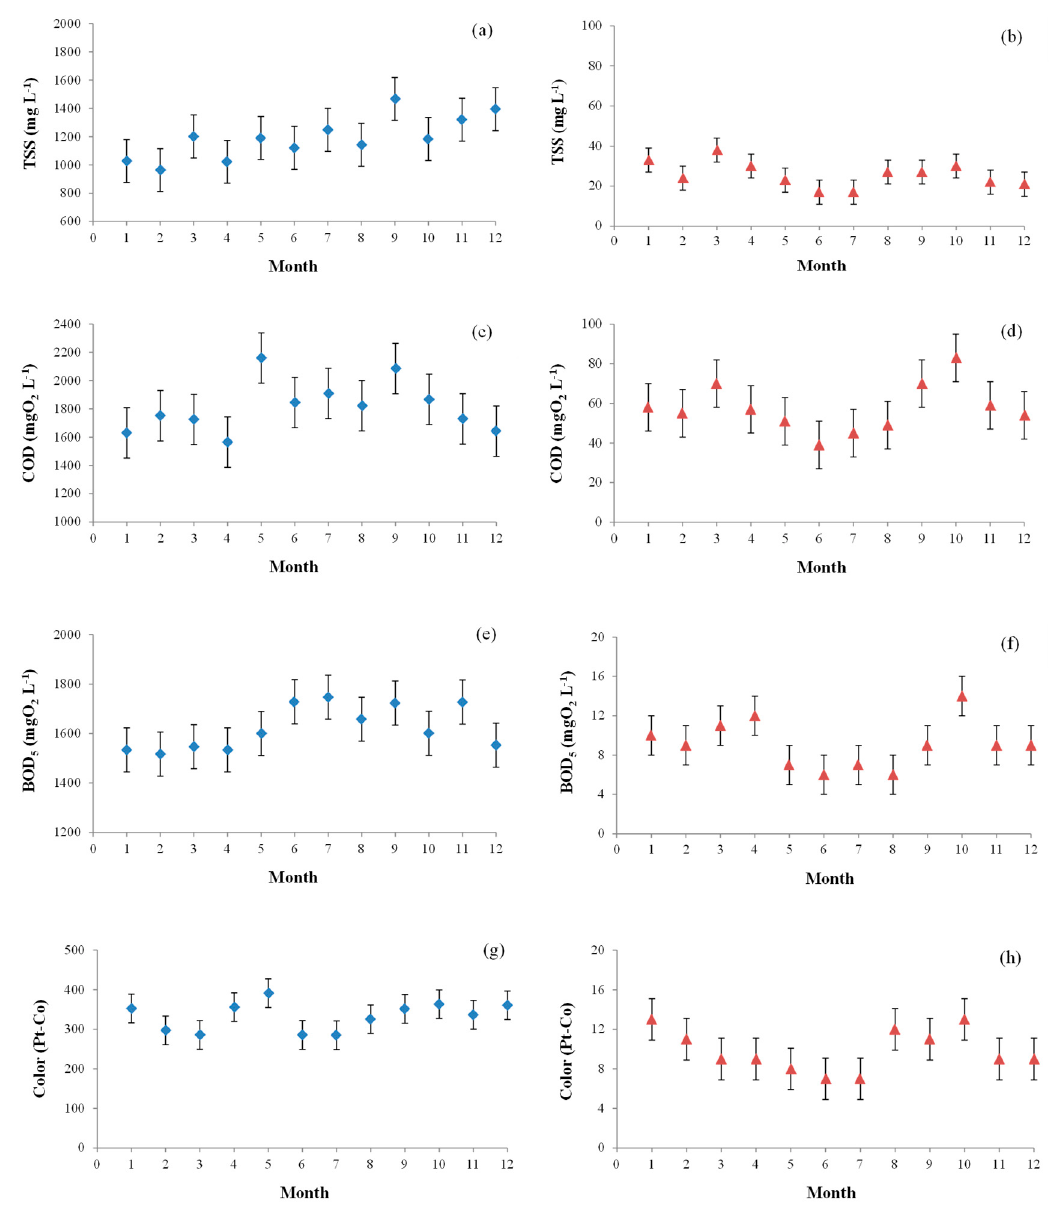
Figure 3. Evolution of total suspended solids (TSS), chemical oxygen demand (COD), seven-day biochemical oxygen demand (BOD 5 ) and color for the influent and effluent of the paper mill wastewater treatment plant. ( a ) TSS of the influent. ( b ) TSS of the effluent. ( c ) COD of the influent. ( d ) COD of the effluent. ( e ) BOD 5 of the influent. ( f ) BOD 5 of the effluent. ( g ) Color of the influent. ( h ) Color of the effluent.